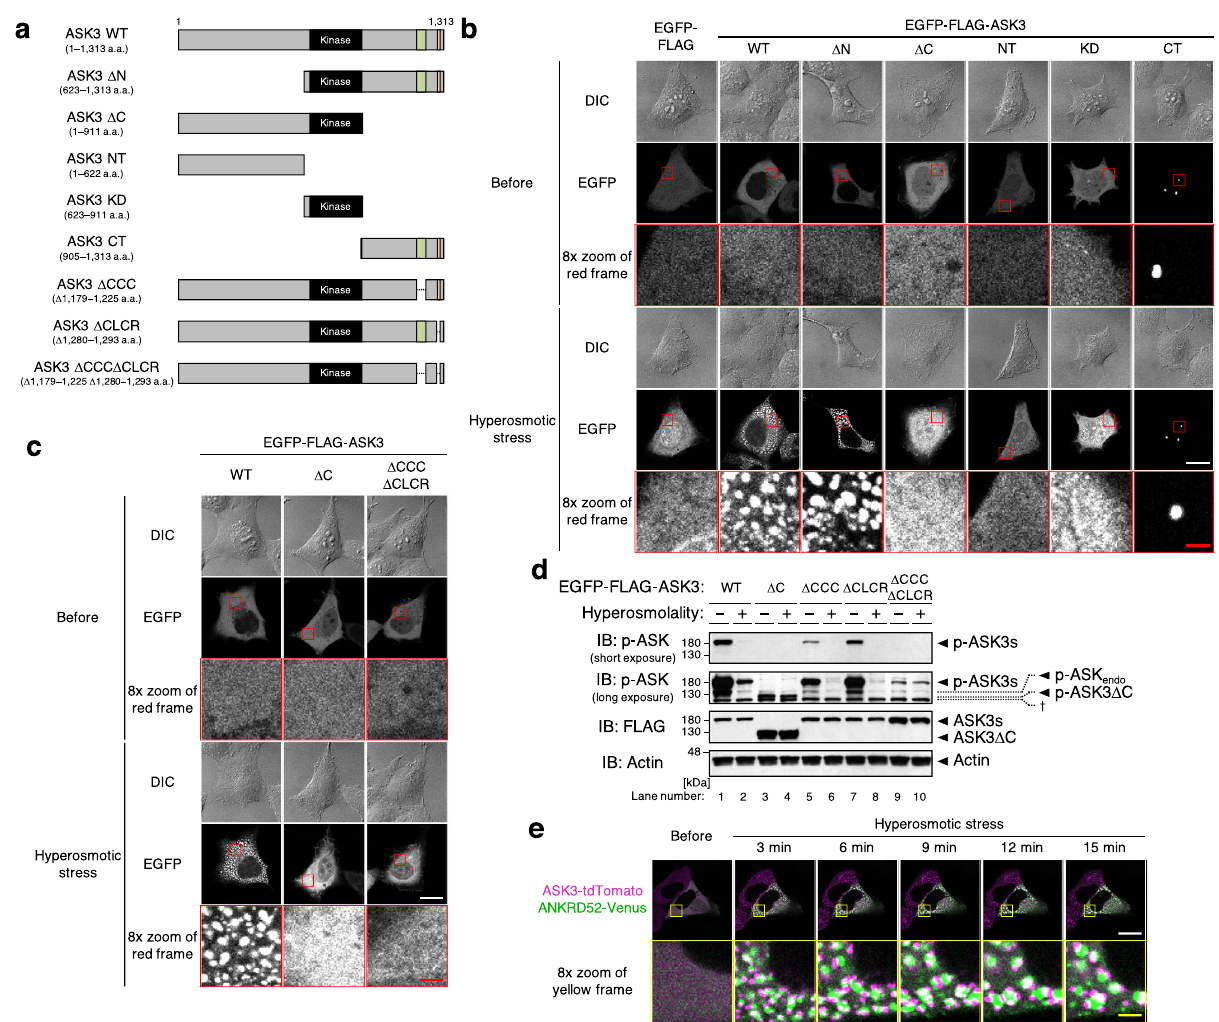
Fig. 3 ASK3 condensation is required for ASK3 inactivation under hyperosmotic stress. a Schematic representation of ASK3 deletion mutants and fragments. The numbers indicate the amino acid (a.a.) positions in wild-type (WT). Black rectangle: kinase domain (652 – 908 a.a.), green rectangle: C- terminus coiled-coil domain (CCC: 1179 – 1225 a.a.), orange rectangle: C-terminus low-complexity region (CLCR: 1280 – 1293 a.a.). b , c Subcellular localization of ASK3 deletion mutants and fragments in HEK293A cells. Hyperosmotic stress: 600mOsm, 10 min. DIC: differential interference contrast, white bar: 20 μ m, red bar: 2.5 μ m. A representative image set from four independent experiments is presented. Note that the signal intensity of DIC cannot be compared among the images. d Requirement of CCC and CLCR for ASK3 inactivation in HEK293A cells. Hyperosmolality ( − ): 300 mOsm; ( + ): 500 mOsm; 10 min. IB: immunoblotting, p-ASK endo : phosphorylation bands of endogenously expressed ASK. † Nonspeci fi c bands. A representative image set from four independent experiments is presented (quanti fi cation: Supplementary Fig. 5a). e Relationship between ANKRD52 and ASK3 condensates in HEK293A cells. Magenta: ASK3-tdTomato, green: ANKRD52-Venus, hyperosmotic stress: 500 mOsm, white bar: 20 μ m, yellow bar: 2.5 μ m. A representative image set from fi ve independent experiments is